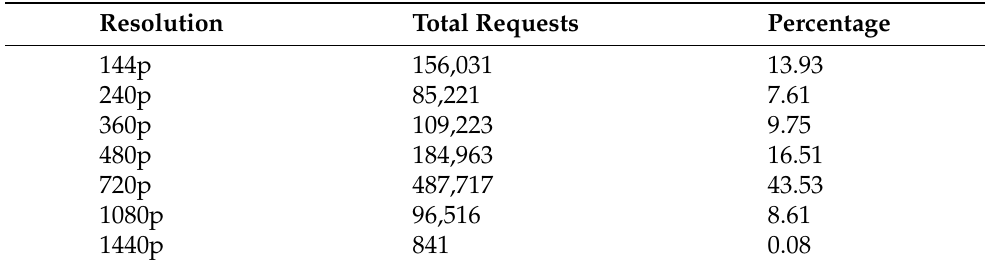
Table 5. Video quality